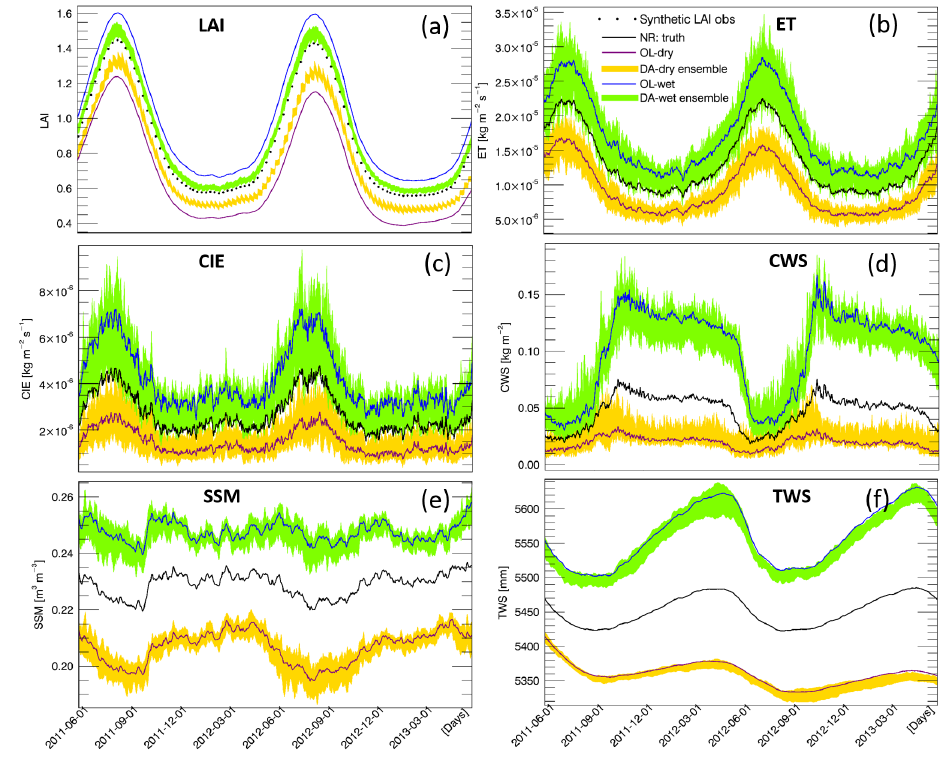
Figure 3. Global averaged daily values of LAI and five water variables (1 June 2011–31 May 2013).